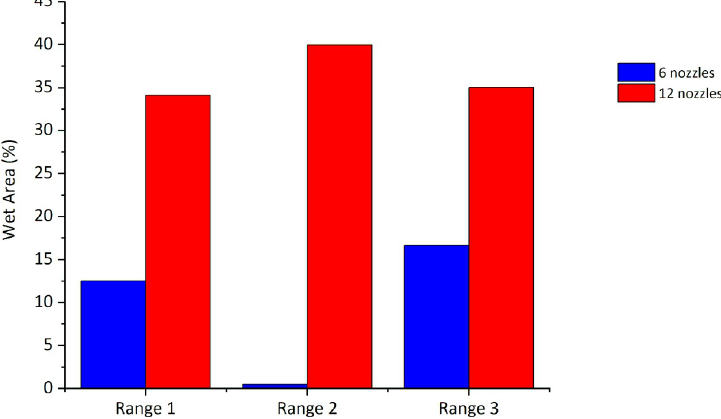
Fig 21. Percentage of wet area in the configurations analyzed for the disinfection chamber with 6 and 12 nebulizer